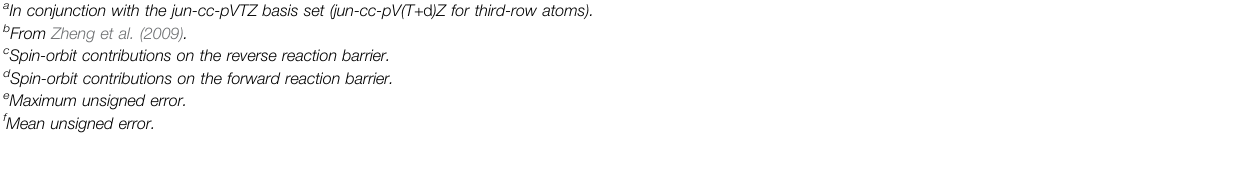
TABLE 3 | Computed equilibrium barrier heightsfor prototypicalextraction and addition reactions:differentcontributionson topofthe jun-Cheap approach. Allvalues arein kJ/mol.